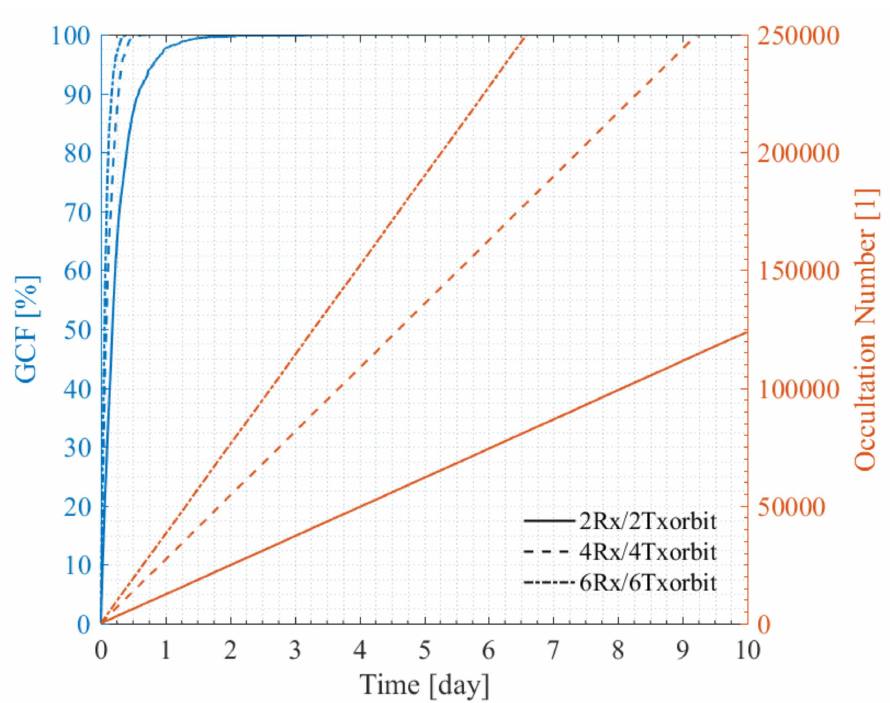
Figure 16. Accumulated time dependence of the global coverage fraction (GCF) (blue lines) and the occultation event number (orange lines) for the 2Rx/2Txorbit, 4Rx/4Txorbit and 6Rx/6Txorbit constellations with the Rxi98 and Txi98 inclination orbital